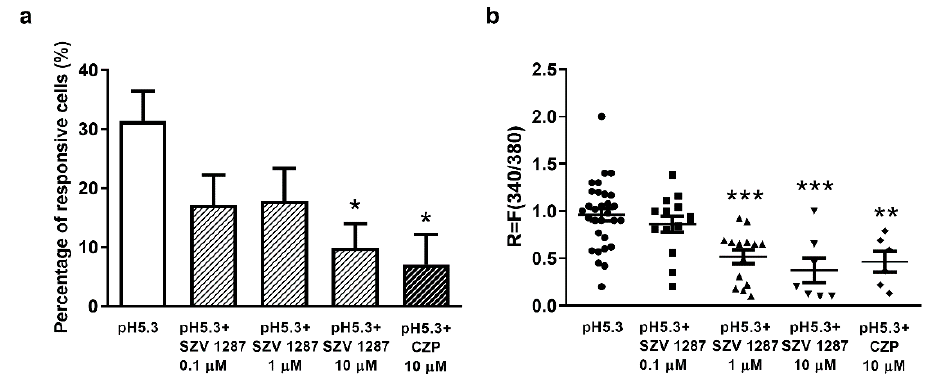
Figure 3. Effect of SZV 1287 on proton-induced TRPV1 receptor activation on cultured primary sensory neurons. ( a ) The percentage of proton-responsive cells at pH 5.3 or pH 5.3 + 10 µ M CZP is presented on control plates and on SZV 1287-pretreated (0.1, 1, and 10 µ M) plates. Ca 2+ -responses are presented in % of total number of examined neurons, * p < 0.05 vs. control; one-way ANOVA (treatment factor F = 3.45, p = 0.017) followed by Dunnett’s multiple comparison test. ( b ) The change in the fluorescence ratio (R = F340/F380) demonstrating the activation of individual cells is presented on the control, SZV 1287-pretreated (0.1, 1 and 10 µ M) and CZP-treated (10 µ M) plates. Each column represents mean + SEM of n = 65–97 cells/group, ** p < 0.01, *** p < 0.001 vs. the control; one-way ANOVA (treatment factor F = 8.73, p < 0.0001) followed by Dunnett’s multiple comparison test. Abbreviation: CZP, capsazepine.